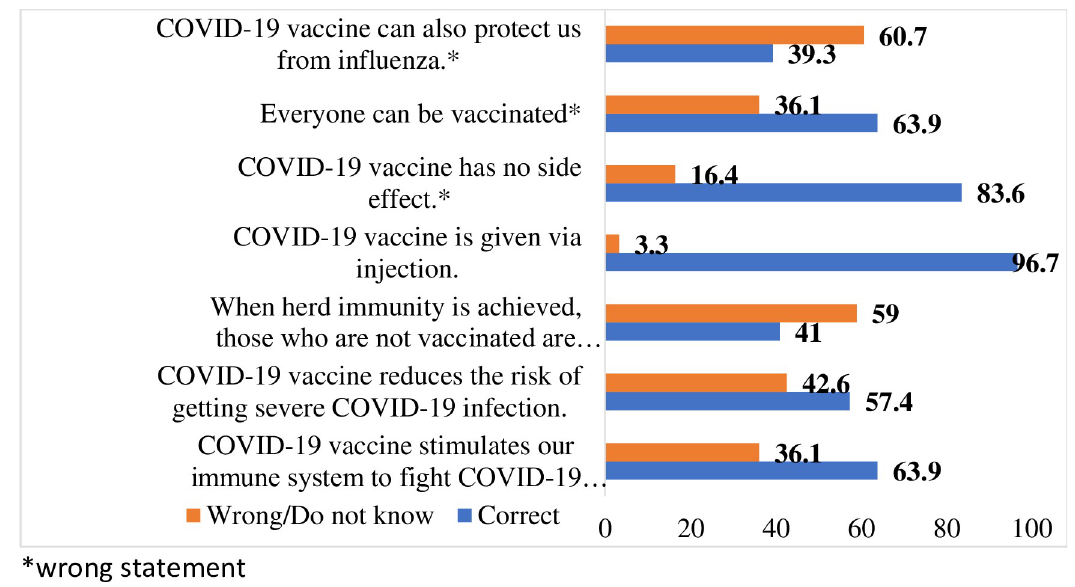
Fig 1. Knowledge item about COVID-19 vaccine ( n =